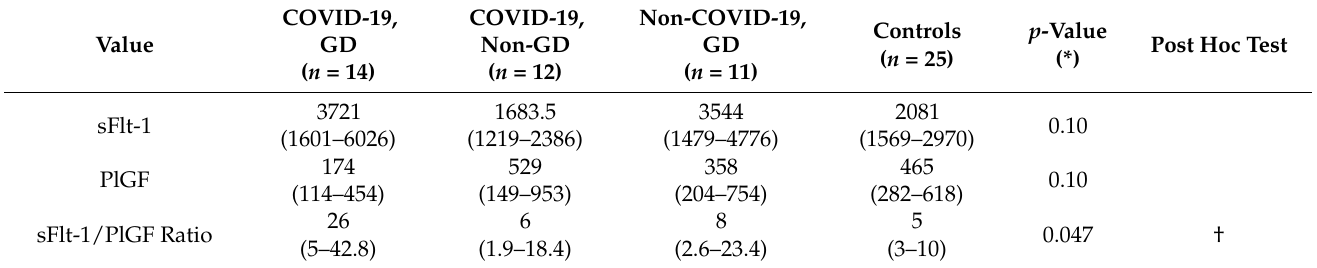
Table 3. Values of soluble blocking factor FMS-like tyrosine Kinase 1 (sFlt-1), placental growth factor (PlGF) and the sFlt-1/PlGF ratio.